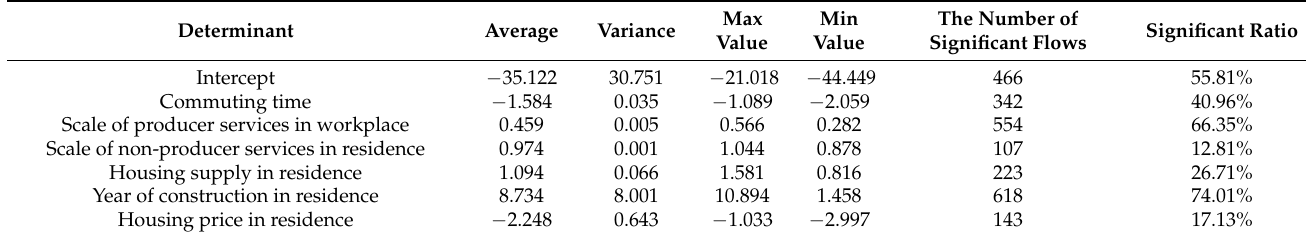
Table 5. Descriptive statistics of the SWIM coefficient estimation